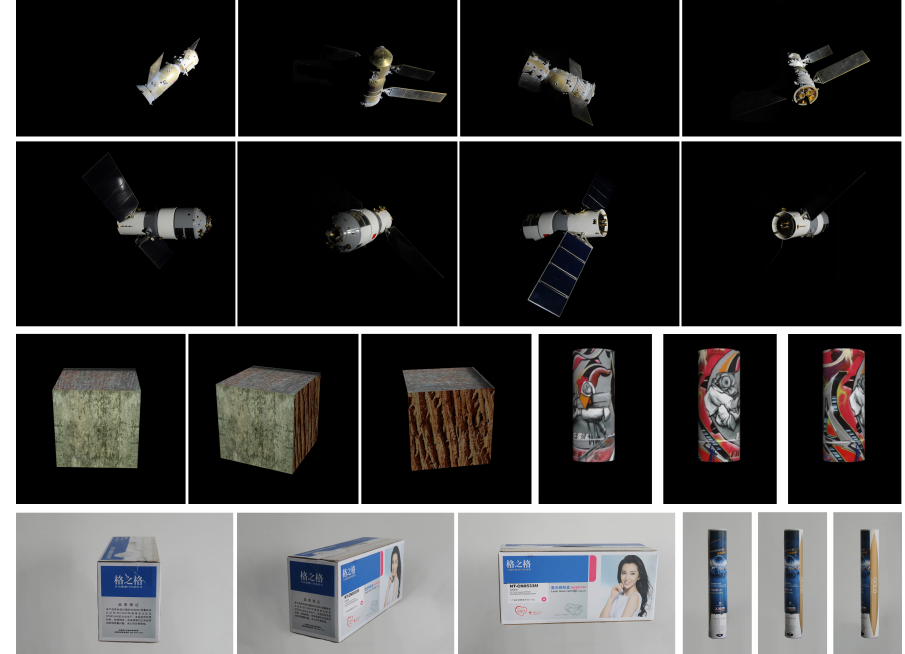
Figure 6. Samples of image data used in our experiments. From top to bottom: image samples of Shenzhou-6 ( the first row ) and Tiangong-1 ( the second row ), rendered images of two 3D CAD models ( the third row ) and real images taken from two actual packages ( the fourth row